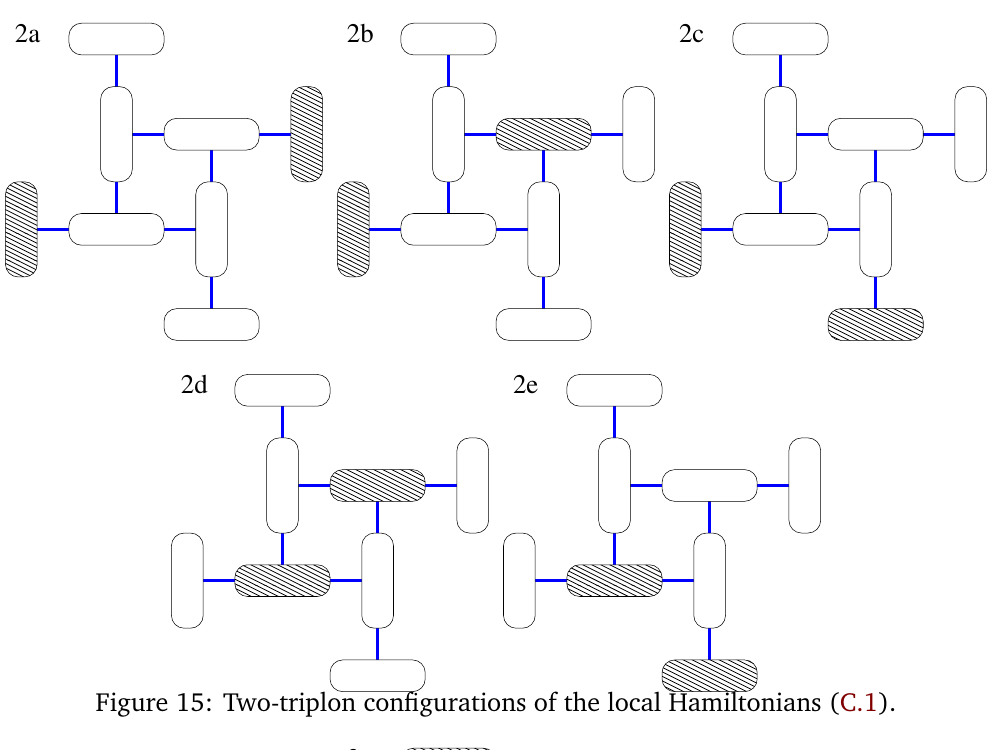
Figure 15: Two-triplon configurations of the local Hamiltonians (C.1).